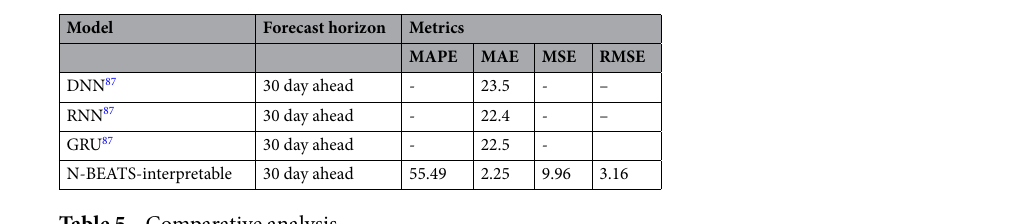
Table 5. Comparative